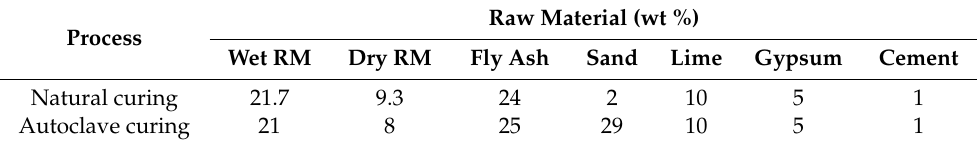
Table 4. Raw materials of bricks by natural curing and autoclave curing [77]. Raw Material (wt %) Process Wet RM Dry RM Fly Ash Sand